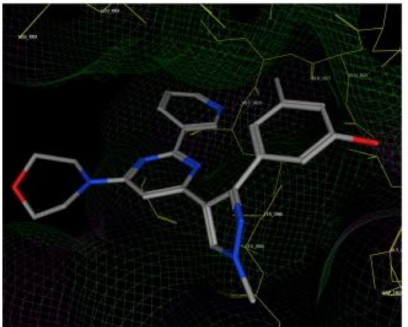
Figure 77. The binding motif of 73 in ROS1 kinase